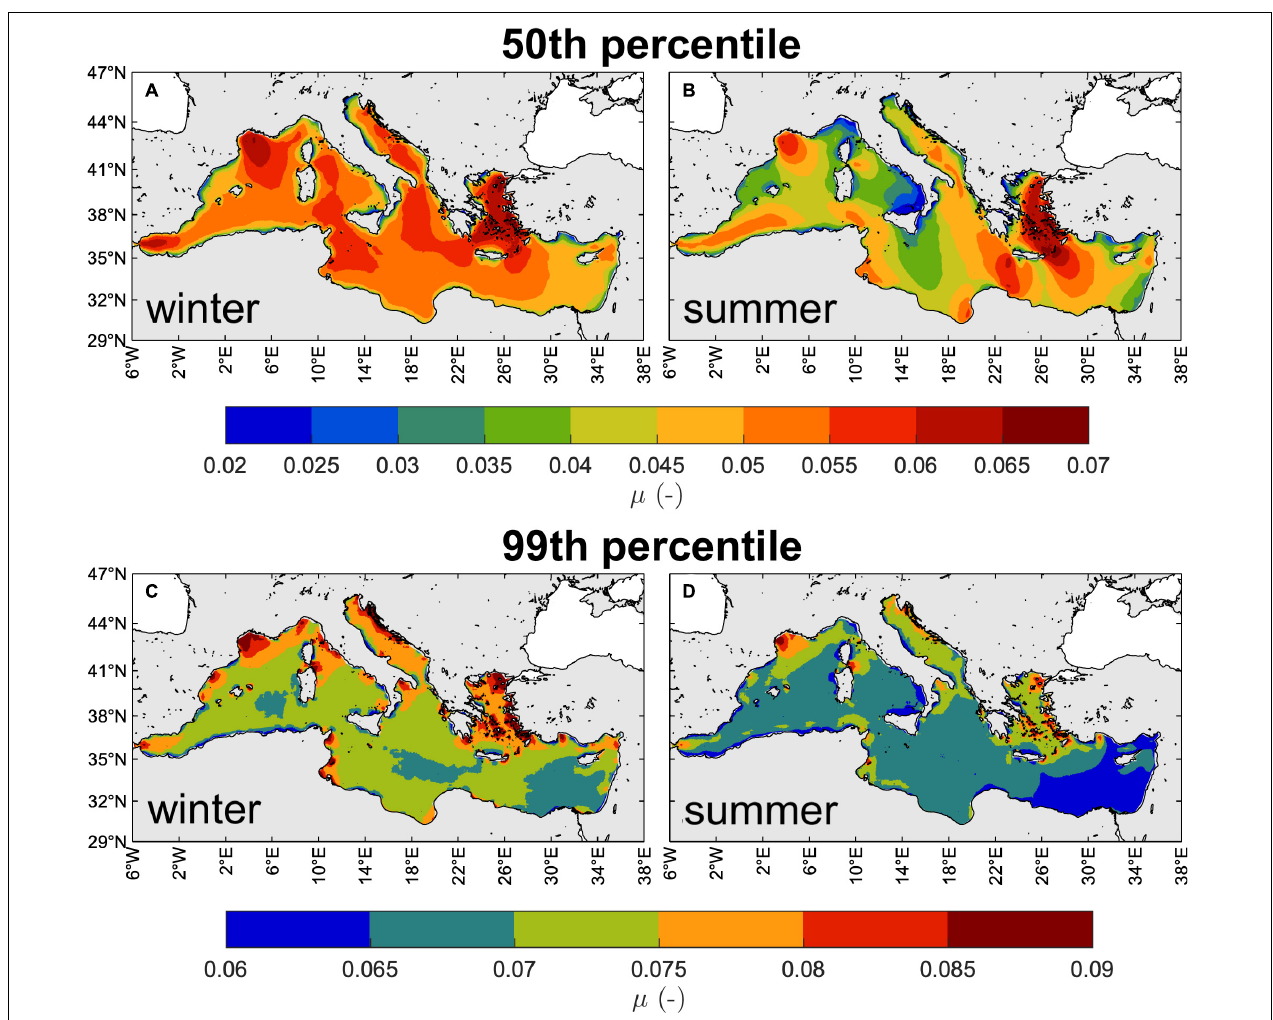
FIGURE 12 | Yearly-averaged seasonal 50th [panels (A,B) ] and 99th [panels (C,D) ] percentiles of µ (1981–2019): winter [NDJFM, panels (A,C) ], summer [JJA, panels (B,D)